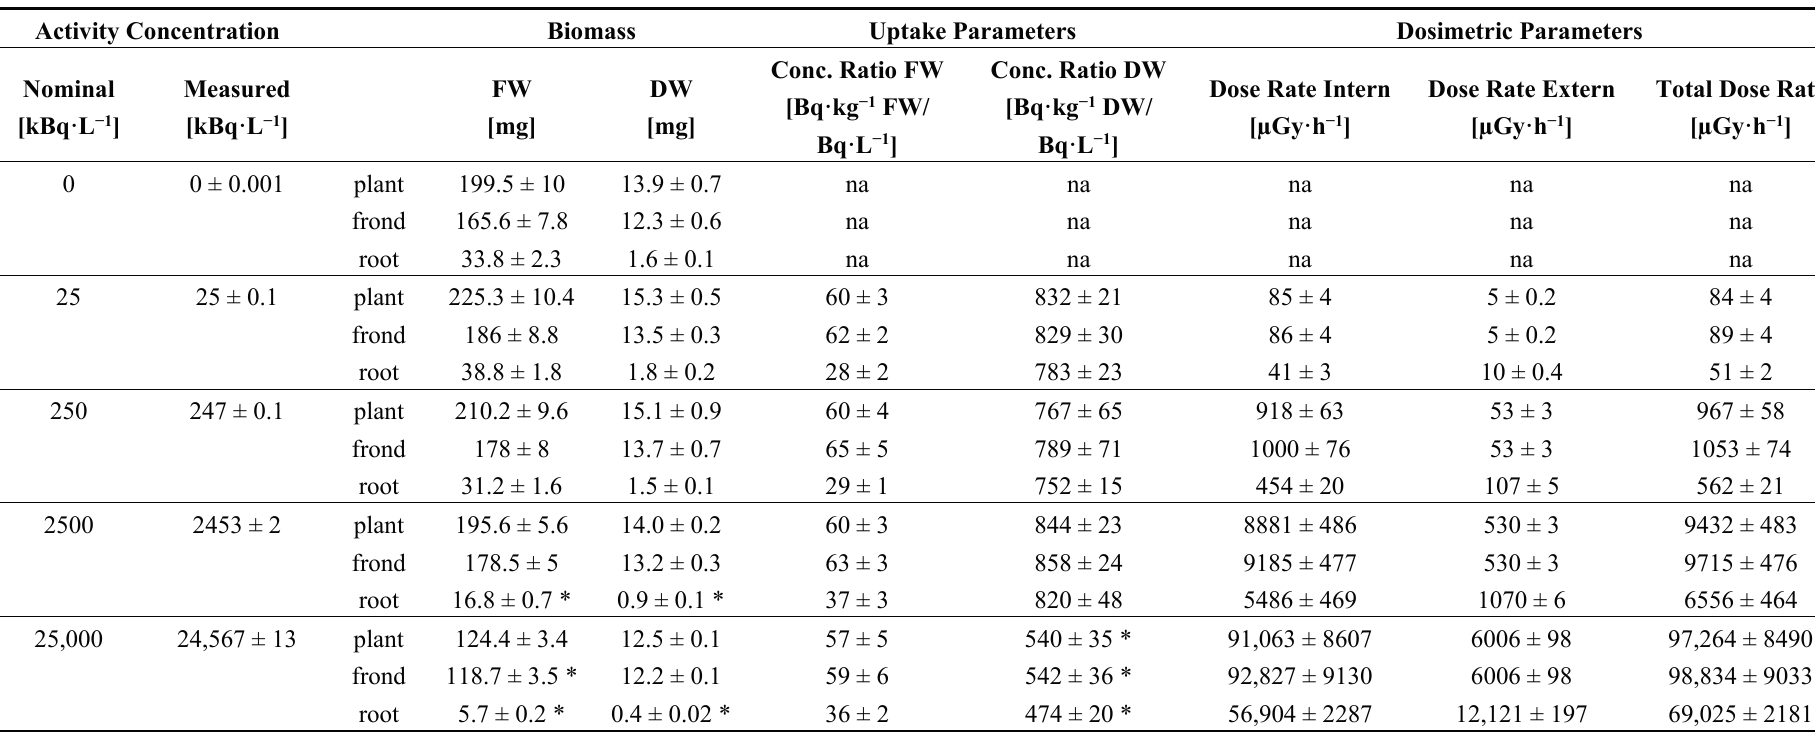
Table 1. Nominal and measured medium activity concentrations of 90 Sr, biomass of L. minor fronds and roots given as fresh weight (FW) and dry weight (DW) of each activity concentration, 90 Sr concentration ratios expressed in fresh weights and dry weights for L. minor fronds and roots after seven days of exposure and the calculated absorbed dose rates in L. minor organs. All values are given as mean ± SE with at least three biological replicates. Significant differences from control plants ( p < 0.05, one-way ANOVA) are given as